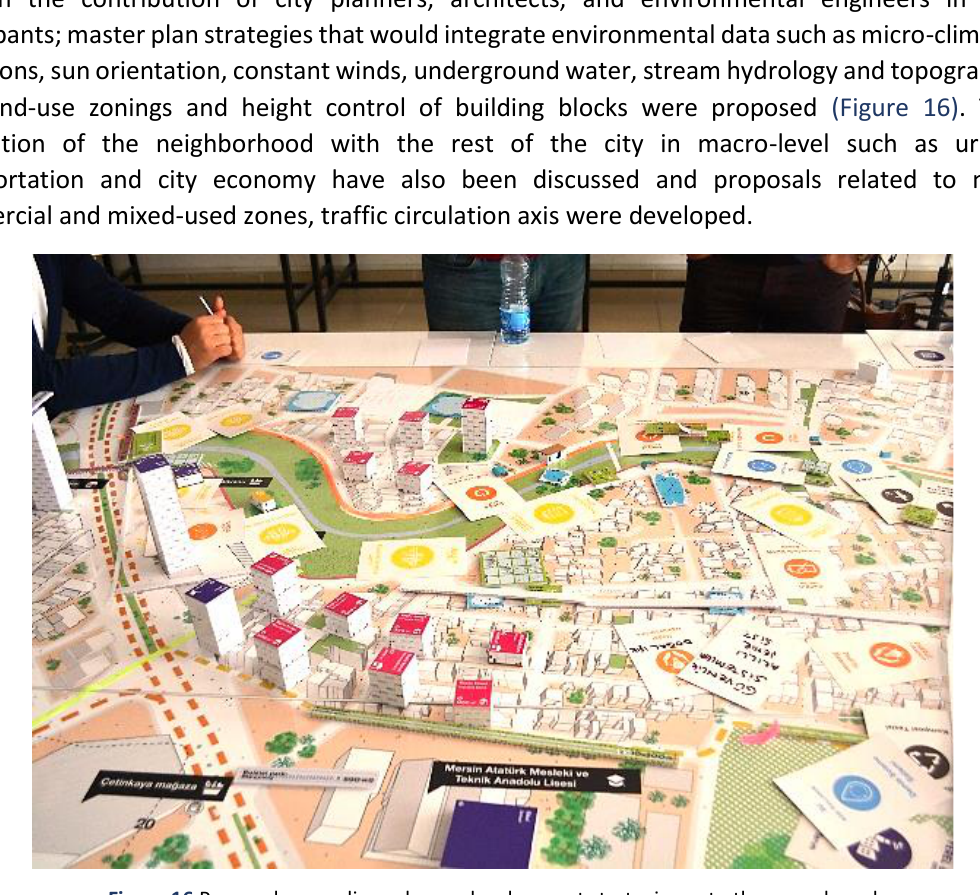
Figure 16 Proposals regarding urban redevelopment strategies onto the game